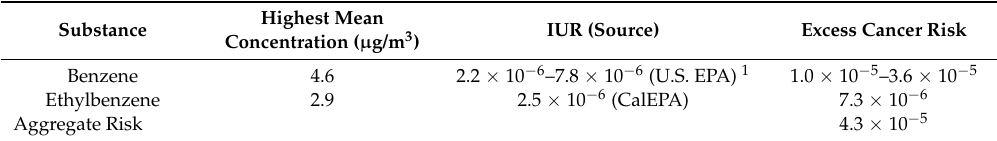
Figure 4. ( a ) Acute and ( b ) chronic hazard quotients (HQ) and hazard indices (HI) for 54 VOCs identified as emitted from OG operations in Colorado. The dotted lines indicate a HQ of 0.1 and 1. Note the log scale. Table 4. Cancer inhalation unit risk (IUR) values and excess cancer risk estimates for VOCs with carcinogenic potential.